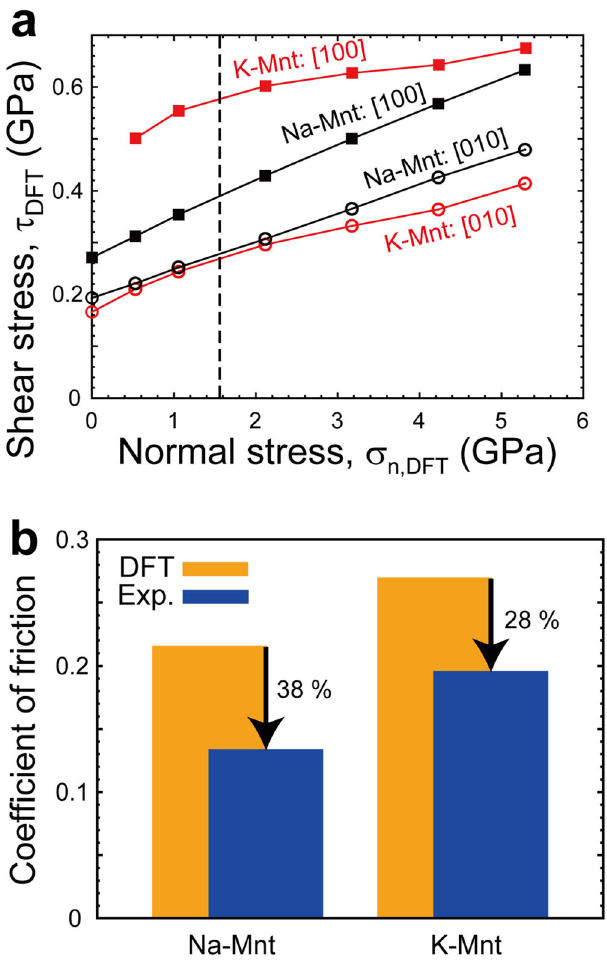
Fig. 3 Comparison of the calculated dry friction with the wet shear experiments. a Calculated shear stress for dry (dehydrated) real area of contact along [100] and [010] directions. The dashed line indicates the experimental indentation hardness of Mnt 28 . The shear stress of K-Mnt: [100] at zero normal stress cannot be calculated because the interlayer distance z determined from the balance between applied normal load and repulsive interlayer force cannot be estimated at some displacements, owing to the strong repulsion between top and bottom layers. The coef fi cients of friction of DFT study are averaged values of [100] and [010] directions at the normal stress of the dashed line. b Comparison of the calculated coef fi cient of dry friction with experimental coef fi cients of wet friction. The experimental values are obtained for brine-saturated Mnts at effective normal stress of 40 MPa. The slightly larger shear stress of Na-Mnt compared to the K-Mnt along the [010] direction can be interpreted as the difference in the stacking structures of top and bottom tetrahedral sheets during the sliding. The shear stress depends on the total potential barrier to be climbed. The potential energy pro fi le of Na-Mnt (Supplementary Fig. 2a) has two maxima at x = 2.6 and 7.5 Å and shear stress is required to climb these two potential barriers. This shear stress is larger than that of the potential barrier of K-Mnt at x = 1 – 4.6 Å (Supplementary Fig. 2b). This comparison indicates that the presence of a local potential minimum of Na-Mnt at x = 4 – 6 Å creates the potential barrier at x = 6 – 7.5 Å, resulting in high shear stress. The interfacial tetrahedra in aluminosilicate layers energetically avoid over- lapping as discussed in pyrophyllite 25 . When interlayer cations are present, the overlapping changes to stabilize the interlayer COMMUNICATIONS EARTH & ENVIRONMENT| (2022) 3:116